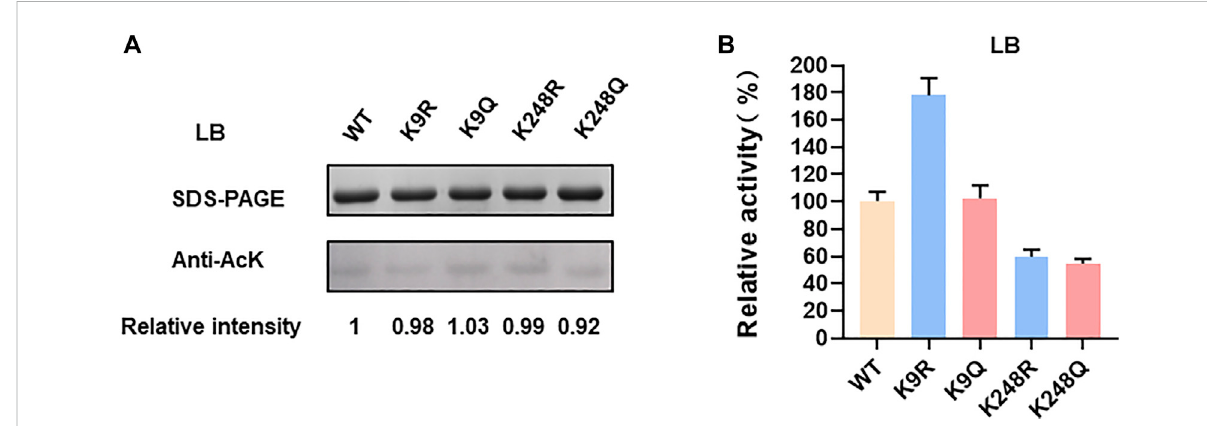
FIGURE 5 LdhA acetylation and enzyme activity in LB cultivated condition. (A) SDS-PAGE and western blot analysis of LdhA variants with lysine substitution. (B) The enzyme activities of LdhA variants with lysine